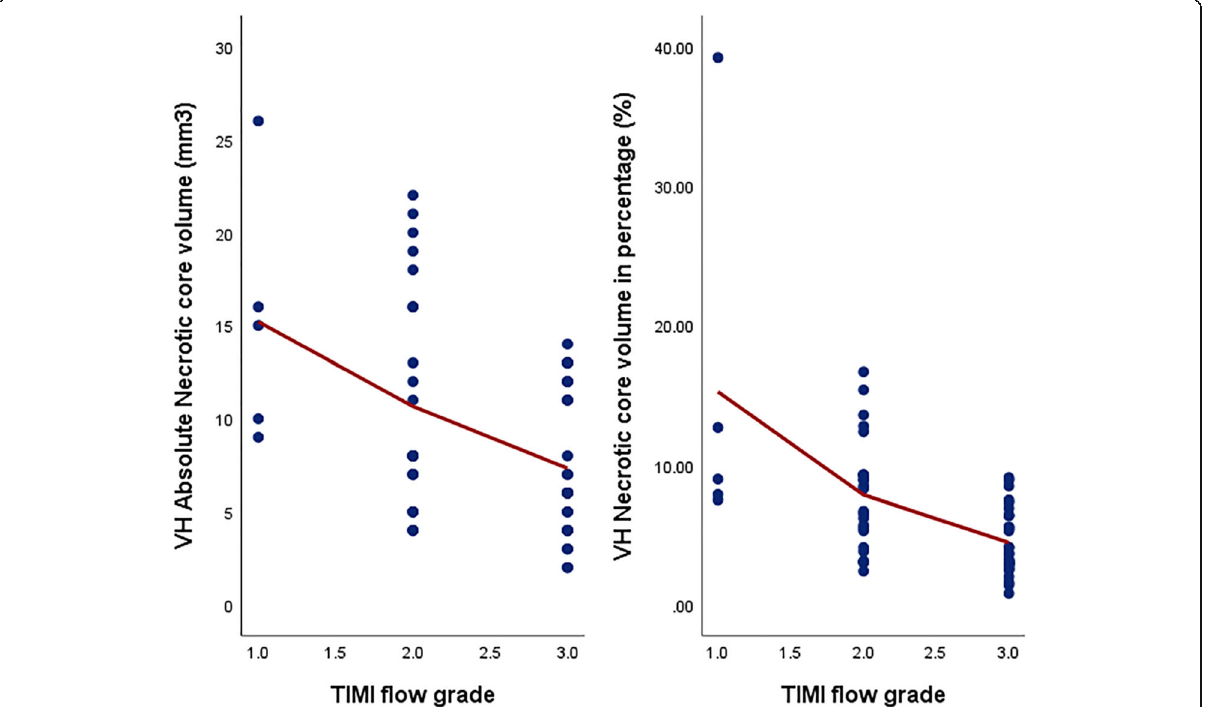
Fig. 3 Absolute necrotic core volume (left panel) and relative necrotic core percentage (right panel) in the culprit plaque, according to the post- fibrinolysis TIMI flow